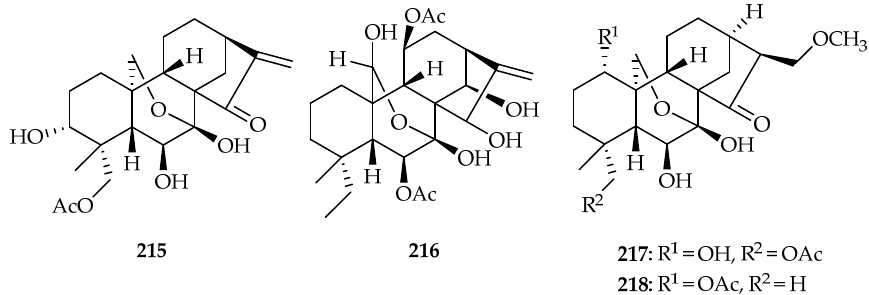
Figure 85. Structures of pharicin D, M, Q, and R 215–218 [133].